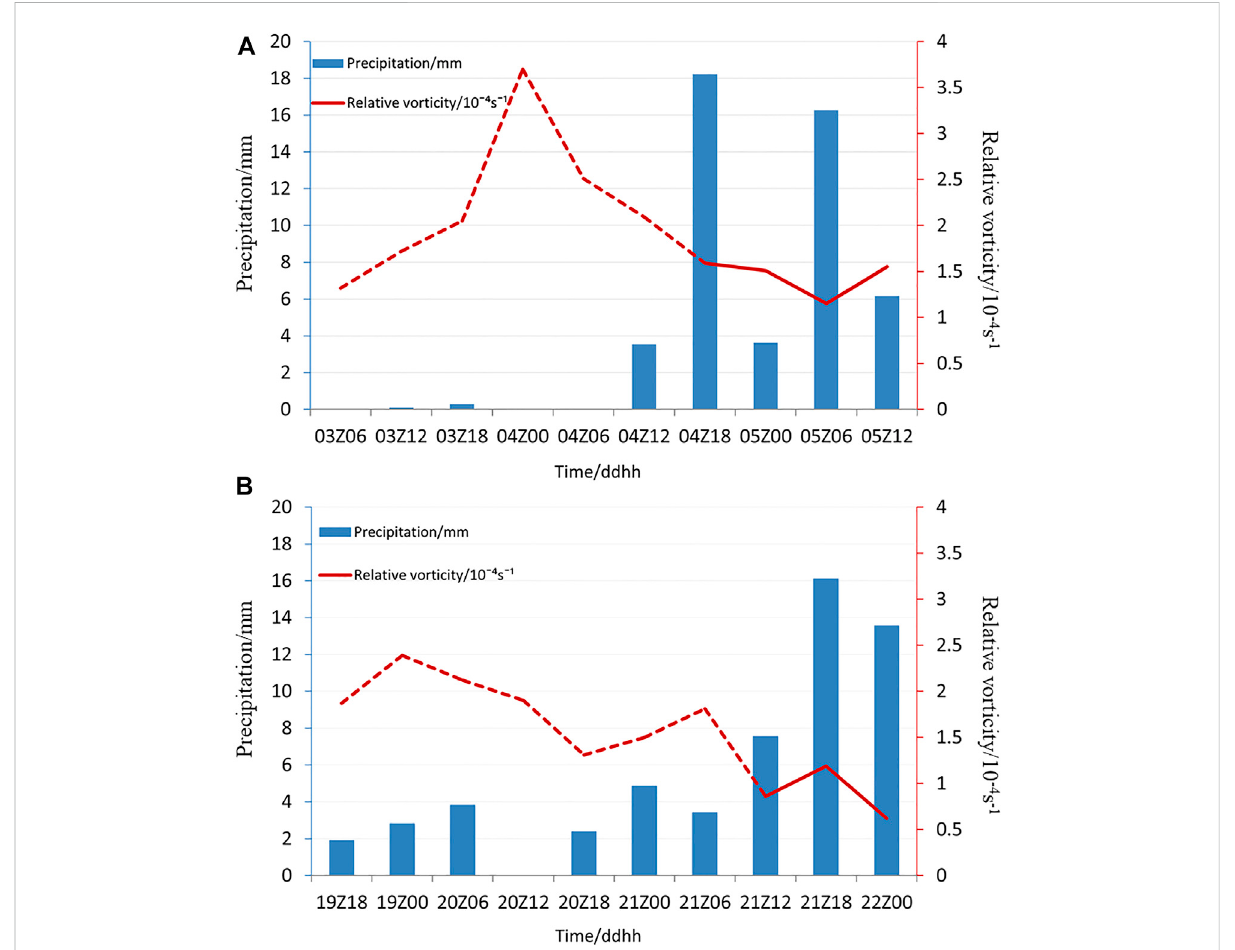
FIGURE 2 Therelativevorticityofvortexcenter(curves,plateaustagesindashedlinesandmoving-outplateaustagesinsolidlines,unit:10 – 4 · s-1)andthe variation of 6-h accumulated precipitation (bars, unit: mm) at 6-h intervals in the range of 2 ° × 2 ° centered at the vortex center in Case 2012 (A) and Case 2013